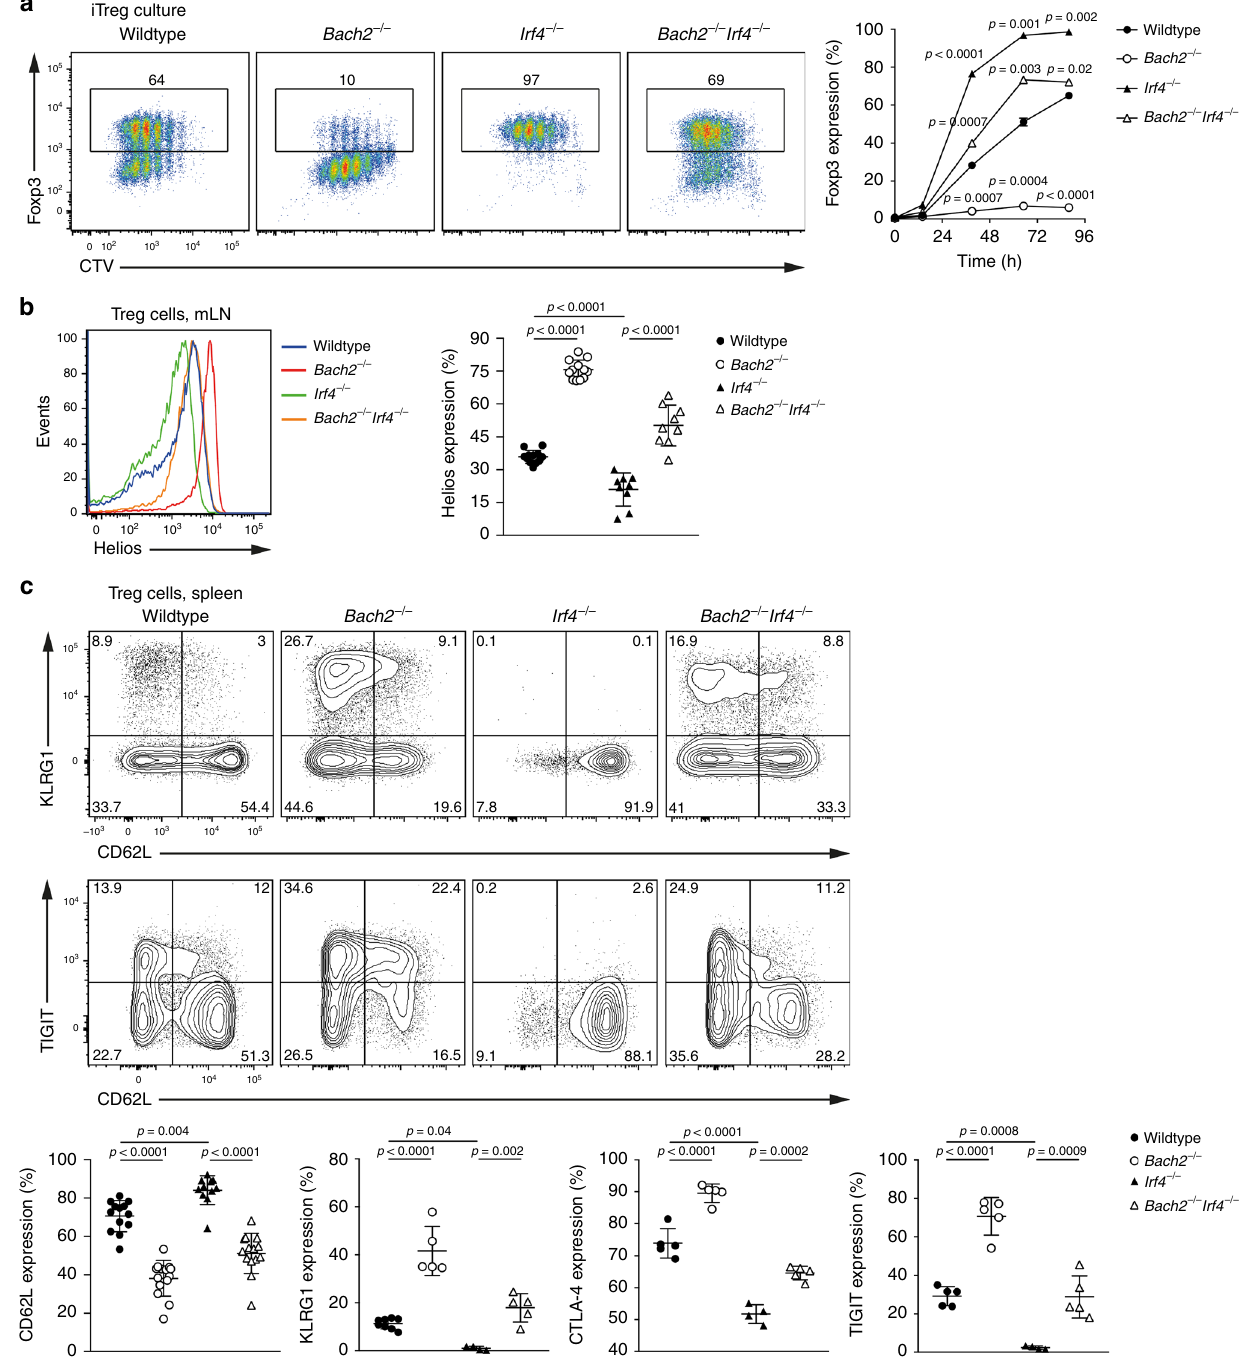
Fig. 6 Loss of IRF4 rescues pTreg and eTreg cell differentiation in the absence of Bach2. a Flow cytometry plots showing Foxp3 expression by CD4 T cells from wildtype, Bach2 − / − , Irf4 − / − , and Bach2 − / − Irf4 − / − mice following culture in Treg cell-inducing conditions, and frequency of Foxp3 expressing cells at the indicated times post culture (right). b Histograms of Helios expression by Treg cells from the mesenteric lymph nodes of wildtype, Bach2 − / − , Irf4 − / − , and Bach2 − / − Irf4 − / − mice (left), and frequency of Helios-expressing Treg cells (right). c Flow cytometry plots showing expression of indicated molecules by splenic Treg cells from wildtype, Bach2 − / − , Irf4 − / − , and Bach2 − / − Irf4 − / − mice, and quanti fi cation of indicated molecules (below). Signi fi cance tested using two-way ANOVA with Dunnett ’ s test for multiple comparisons ( a ) or using ordinary one-way ANOVA with Tukey ’ s test for multiple comparisons ( c ). Data are representative of ( a ) or pooled ( b , c ) from three independent experiments. Error bars denote mean ± S.D. Source data are provided as a Source Data fi